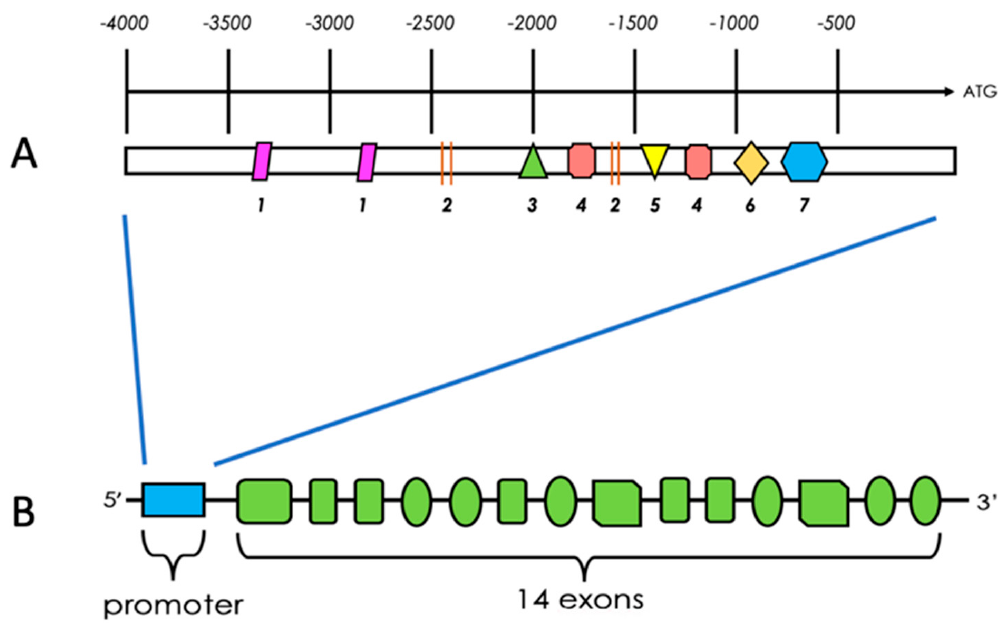
Figure 3. Schematic structure of the 5’ promoter ( A ) of the PFKFB4 gene ( B ). PFKFB4 contains 14 represent: 1—GRE (glucocorticoid response element), 2—AP-2 (activating protein 2), 3—specific protein 1, 4—TATA box, exons. Numbers in ( A ) represent: 1—GRE (glucocorticoid response element), 2—AP-2 (activating 5—serum response element, 6—hypoxia response element, 7—ETF. The schematic structures are based on Gomez et al. protein 2), 3—specific protein 1, 4—TATA box, 5—serum response element, 6—hypoxia response (2004)